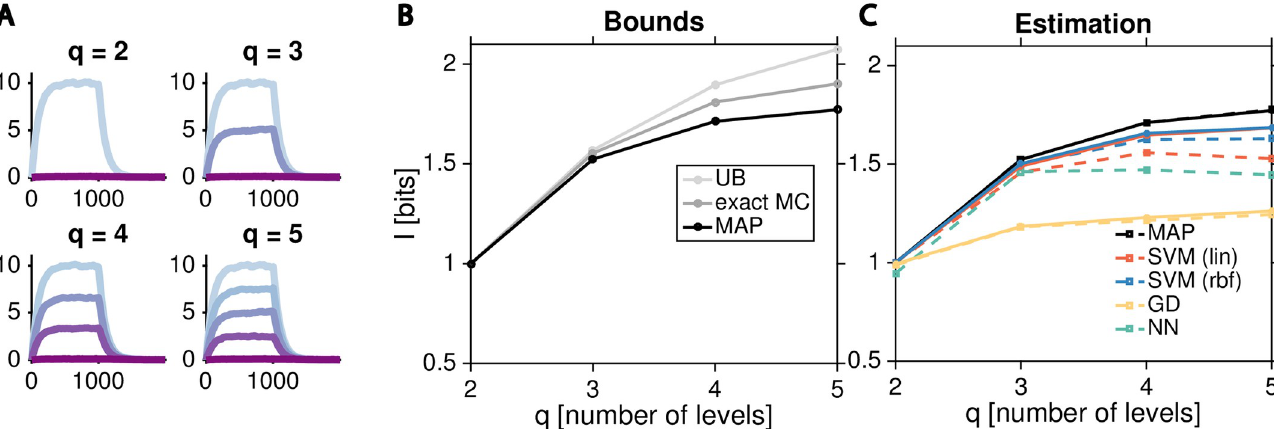
Fig 6. Information estimation for multilevel inputs. (A) Extension of Example 2 from Fig 2B to q = 2, ... , 5 discrete inputs. We chose the inputs such that the response for the system at T < 1000 converges towards q equally spaced levels with the same dynamic range as the original example; dynamics at T � 1000 remain unchanged from the original Example 2. (B) Model-based information bounds as a function of the number of input levels for trajectories represented as d = 100 dimensional vectors: exact Monte Carlo calculation (dark gray), MAP decoding bound (black), upper bound (light gray). (C) Performance of model-free estimators, as indicated in the panel, compared to the MAP bound (black). Dashed lines show estimations using N = 10 3 sample trajectories per condition, solid lines using N = 10 4 samples per condition; in both cases, we show an average over 20 independent replicates, error bars are suppressed for readability.